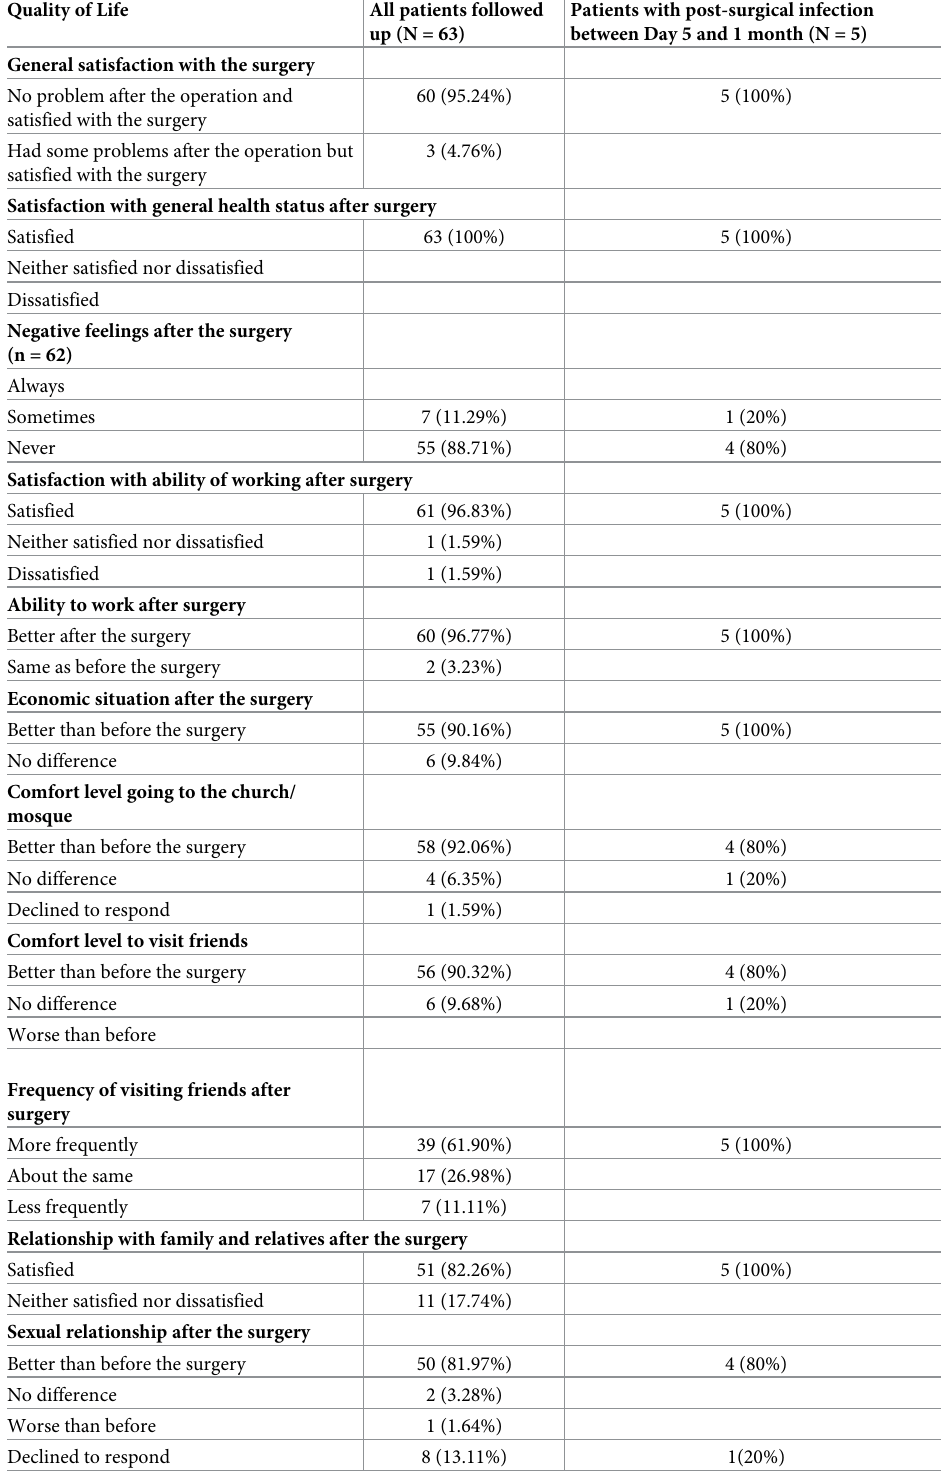
Patients with post-surgical infection up (N = 63) between Day 5 and 1 month (N = 5) 60 (95.24%) 5 (100%) 3 (4.76%)